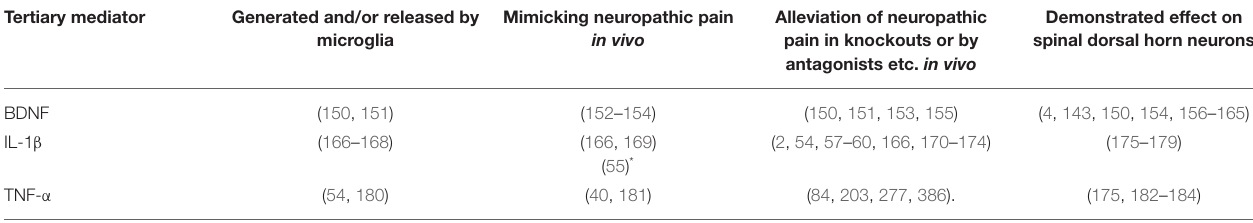
TABLE 3 | Tertiary mediators produced by microglia to affect spinal dorsal horn neurons. Tertiary